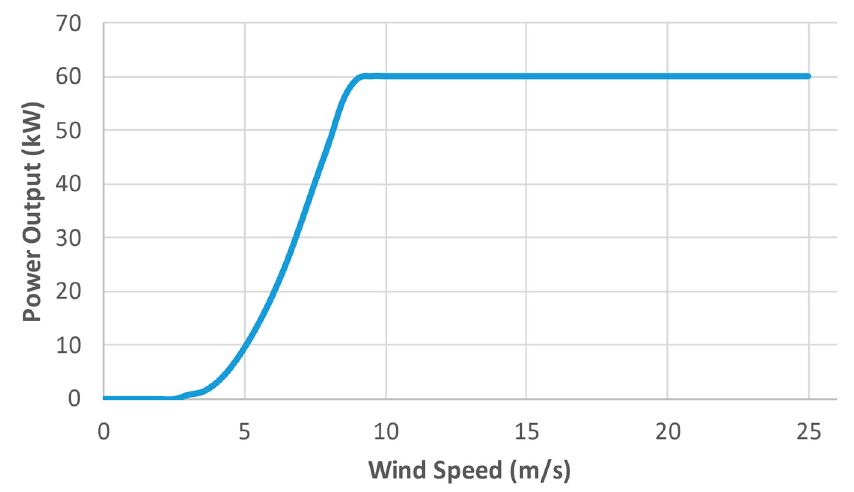
Figure 7. Aeolos-H 60 kW WT power curve [37]. Table 1. Characteristics of the HMU campus microgrid components.